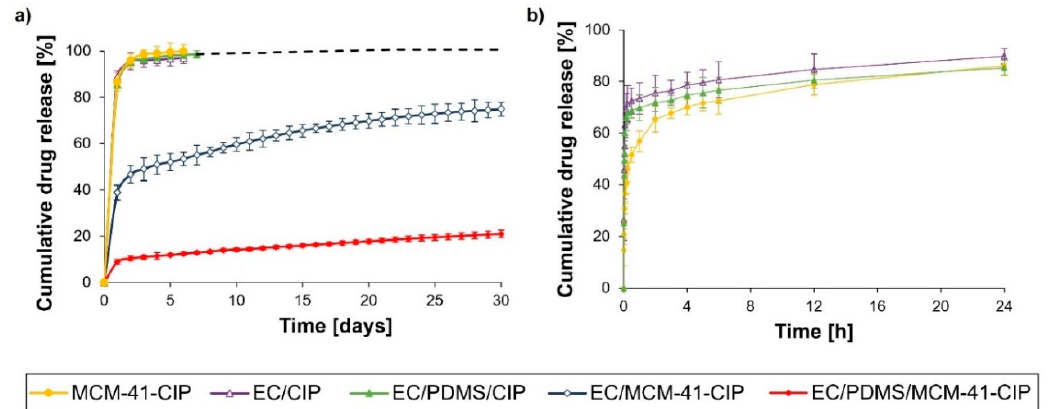
Figure 4. The CIP release profiles of obtained composites: EC / CIP, EC / PDMS / CIP, EC / MCM-41-CIP, EC / PDMS / MCM-41-CIP and MCM-41-CIP sample ( a ), and first 24 h release profiles of MCM-41-CIP, EC / CIP, EC / PDMS / CIP samples ( b ).